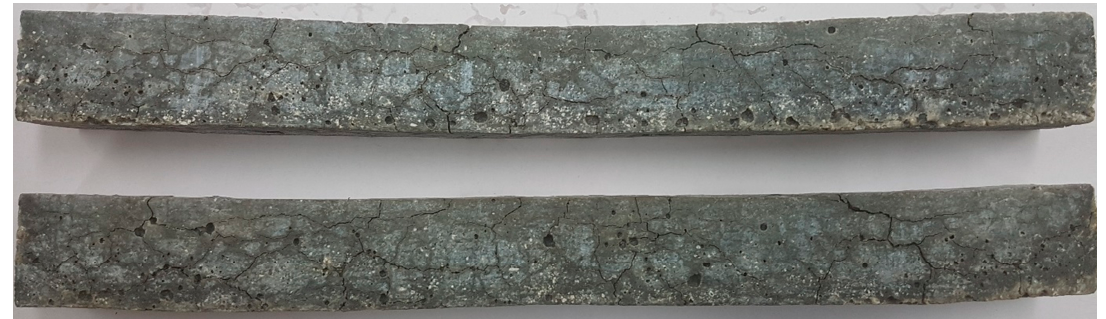
Figure 2. Cracked mortar specimens at 107 days of immersion in NaOH solution.